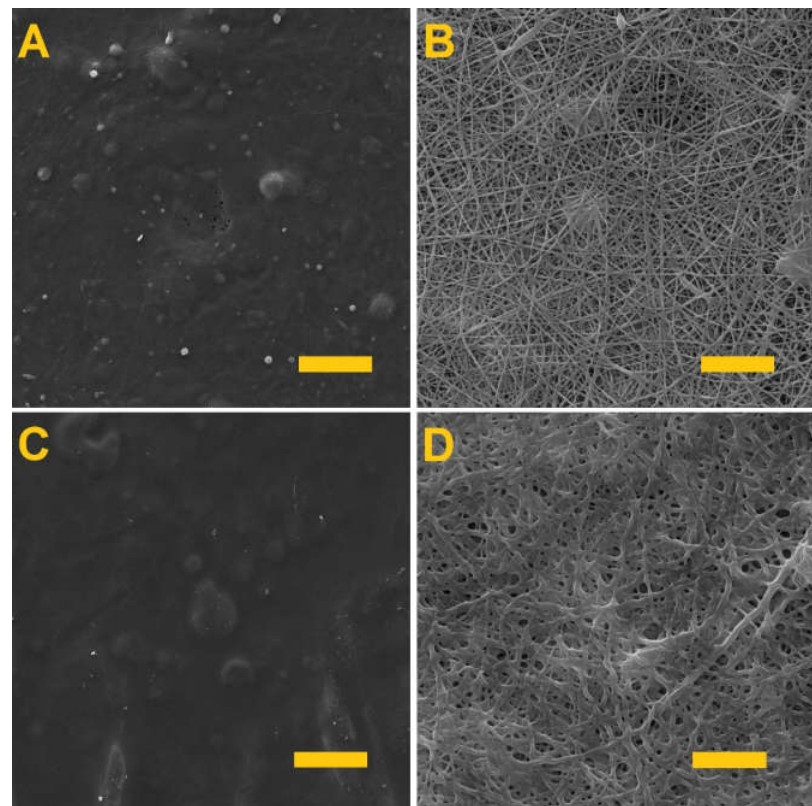
Figure 2. The fiber layers following crosslinking. ( A ) PVA/gelatin after 24 h of crosslinking; scale 50 µ m. ( B ) PVA/gelatin after 4 h of crosslinking; scale 10 µ m. ( C ) PVA/alginate after 24 h of crosslinking; scale 50 µ m. ( D ) PVA/alginate after 4 h of crosslinking; scale 10 µ m.